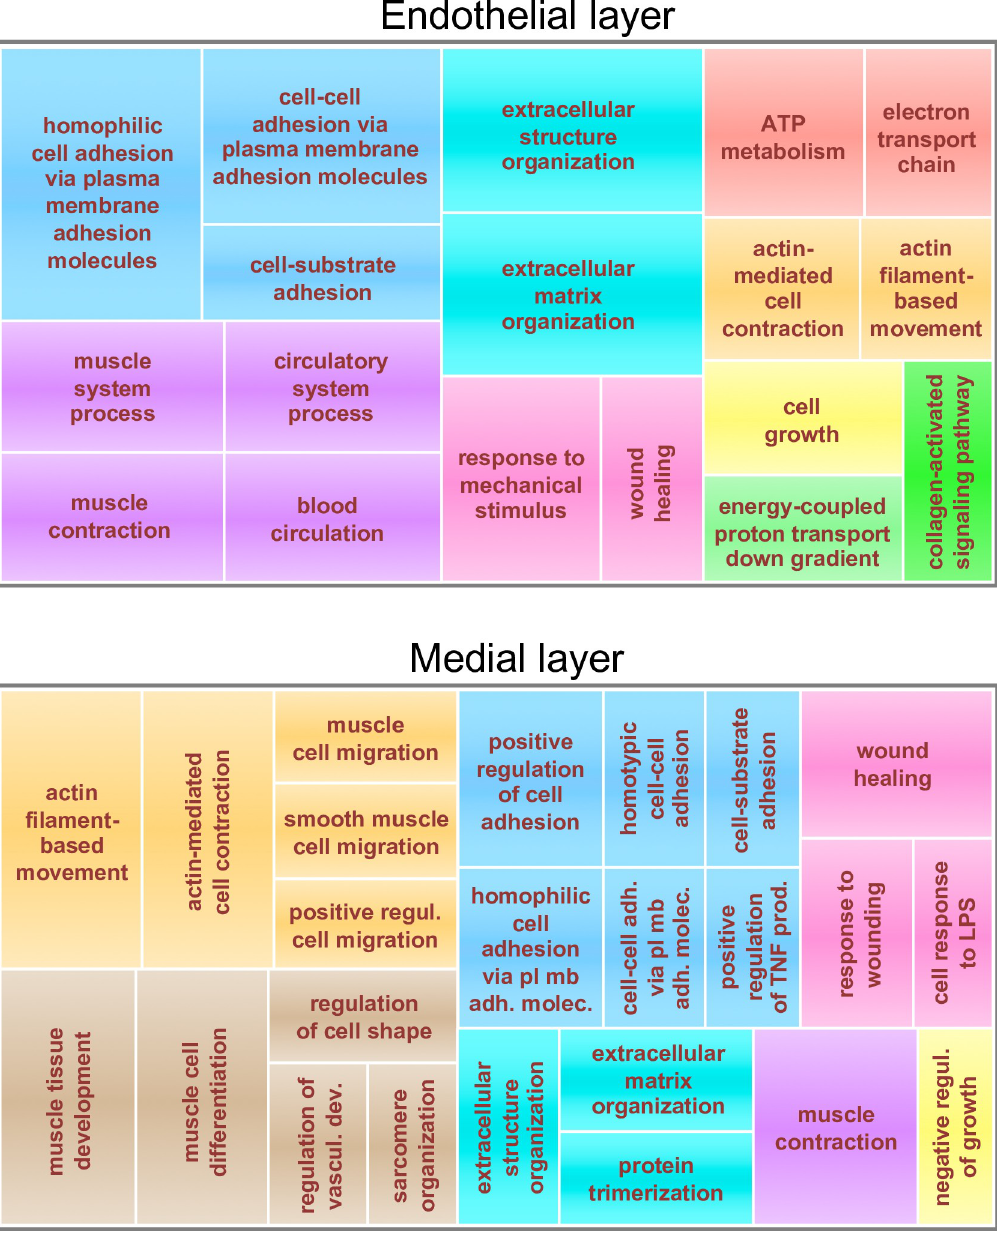
Fig 10. Gene ontology analysis. Genes with significant differential expression in Poldip2 -/- vs. control from endothelial (top) and medial (bottom) layers, were classified using the clusterProfiler software. The resulting lists of GO terms were further summarized using the REVIGO software. The final treemaps represent broad categories of GO terms as boxes with areas proportional to the adjusted probabilities of differentially expressed genes. Related categories are represented in clusters of various